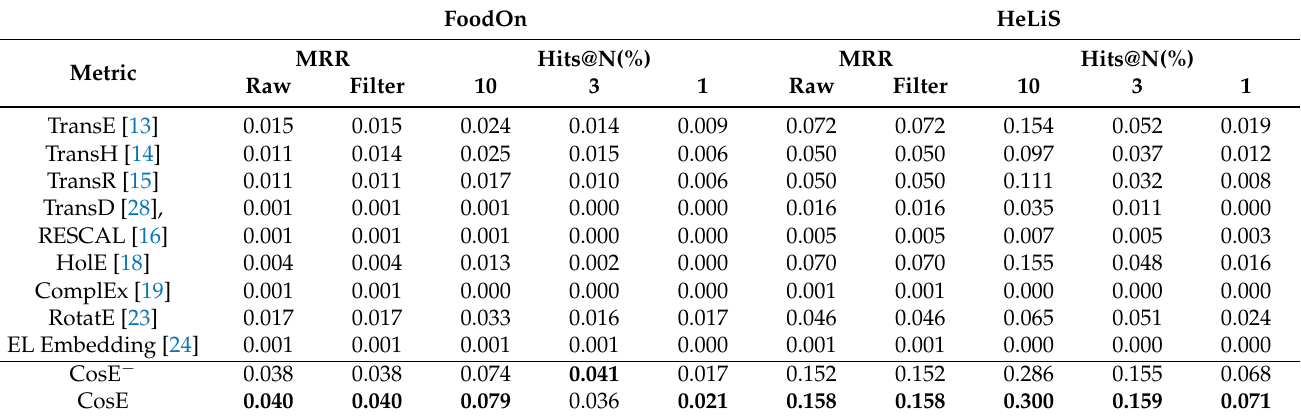
Table 5. The results of FoodOn and HeLiS on link prediction about subclassOf